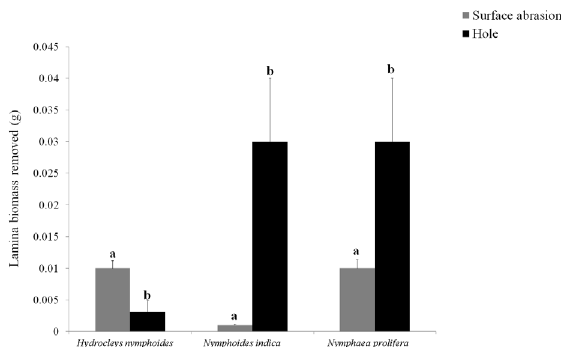
Figure 2 - The lamina biomass removed (g) by surface abrasion and holes per leaf lamina on floating-leaf macrophytes in the growth period. Different letters indicate means statistically different between sampling dates.